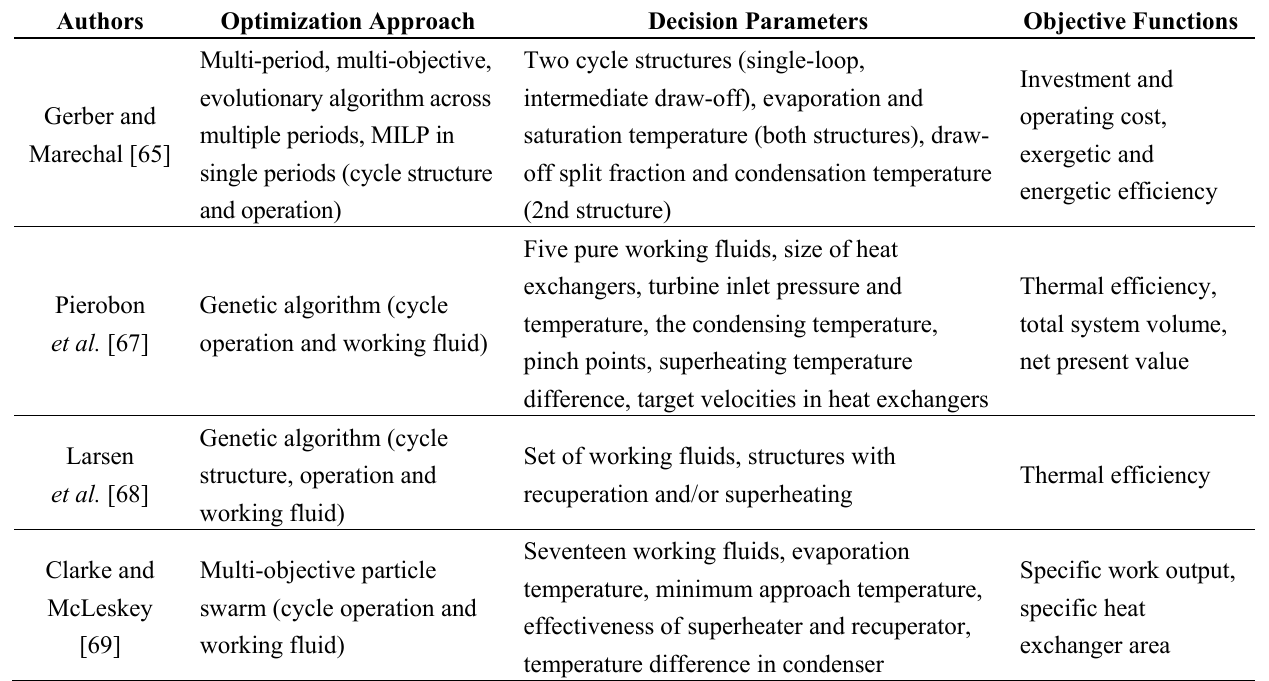
Table 5. Optimum cycle structure, operating/sizing parameters and working fluids are selected simultaneously from a pre-determined set of